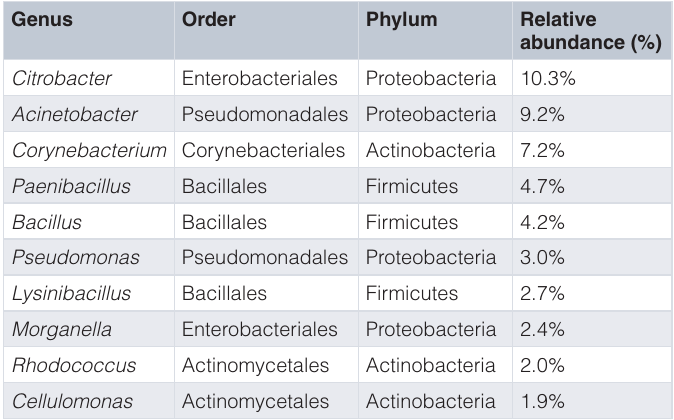
Table 2. Predominant bacterial genera identified from the nostrils of healthy medical students.